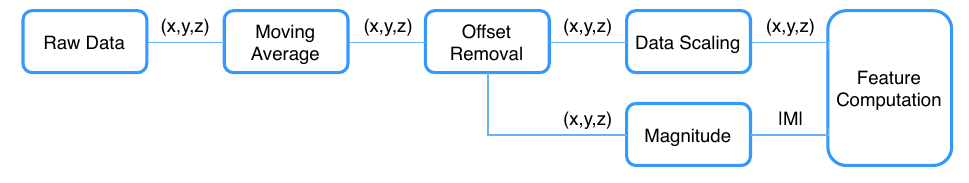
Figure 3. The flows of data in preprocessing stage.